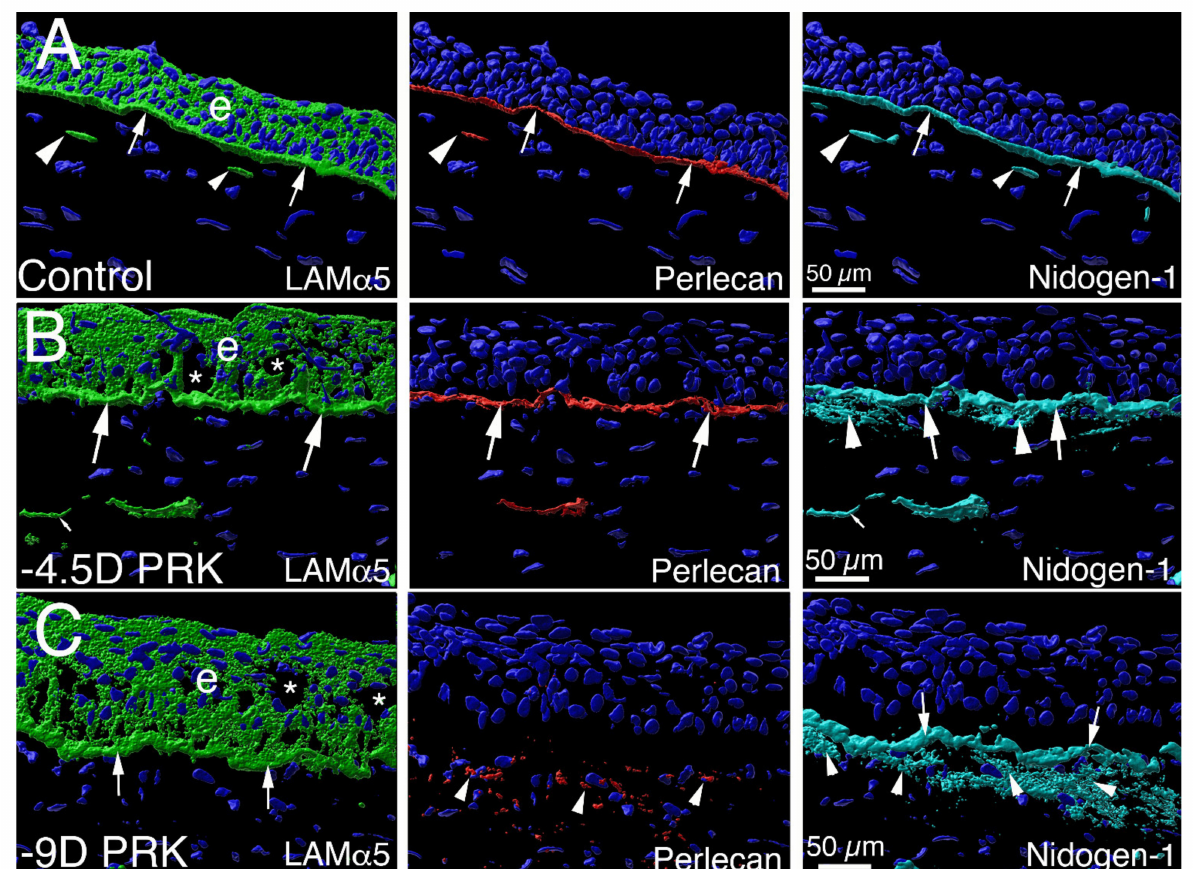
Figure 7. Defective perlecan EBM incorporation in a PRK injured rabbit cornea that developed scarring stromal fibrosis and myofibroblasts. Confocal microscopy Imaris 3D constructed images of triplex IHC for laminin alpha-5, perlecan and nidogen-1 in an unwounded control cornea and corneas with moderate − 4.5D PRK and severe − 9D PRK epithelial-stromal injury [5]. ( A ) Laminin alpha-5 (green) was detected in the epithelium (e) and in the EBM (arrows) in an unwounded cornea. Two DAPI-negative vesicles with laminin alpha-5 (arrowheads) are present in the anterior stroma adjacent to the EBM. These were likely produced by keratocytes to contribute to maintenance of the EBM. Perlecan (red) was detected in the EBM (arrows), and in vesicles in the anterior stroma (arrowhead). Nidogen-1 (blue gray) is a major component in the EBM (arrows) and is present in secretory vesicles in the anterior stroma (arrowheads). ( B ) A cornea at 1 month after surgery that had moderate epithelial-stromal injury ( − 4.5D PRK) and did not develop myofibroblasts or scarring stromal fibrosis (see Figure 1B). The laminin alpha-5, perlecan and nidogen-1 localization in the EBM are similar to that noted in the unwounded cornea (large arrows), except there are increased nidogen-1 (arrowheads) in the subepithelial stroma surrounding stromal keratocyte/corneal fibroblast cells. Vesicles (small arrows) that are DAPI-negative are present in the anterior stroma and contain one or more of the EBM components. ( C ) In a cornea 1 month after more severe epithelial-stromal injury ( − 9D PRK) there is greater stromal opacity and myofibroblasts (see Figure 1C). Laminin alpha-5 and nidogen-1 (arrows) EBM localization is similar to that noted in the unwounded control cornea. Perlecan, however, was not detected at significant levels in the EBM, even though it is present within and surrounding myofibroblasts (arrowheads) in the anterior stroma. Stromal nidogen-1 (arrowheads) surrounding myofibroblasts is also present at high levels in the anterior stroma. Blue in all panels is DAPI-stained nuclei. e is epithelium. * indicates artifactual defects in the epithelium which are often noted in PRK corneas that are cryo-sectioned in the first 1 to 2 months after surgery while the EBM has not fully regenerated. Reprinted with permission from de Oliveira et al. Exp Eye Res